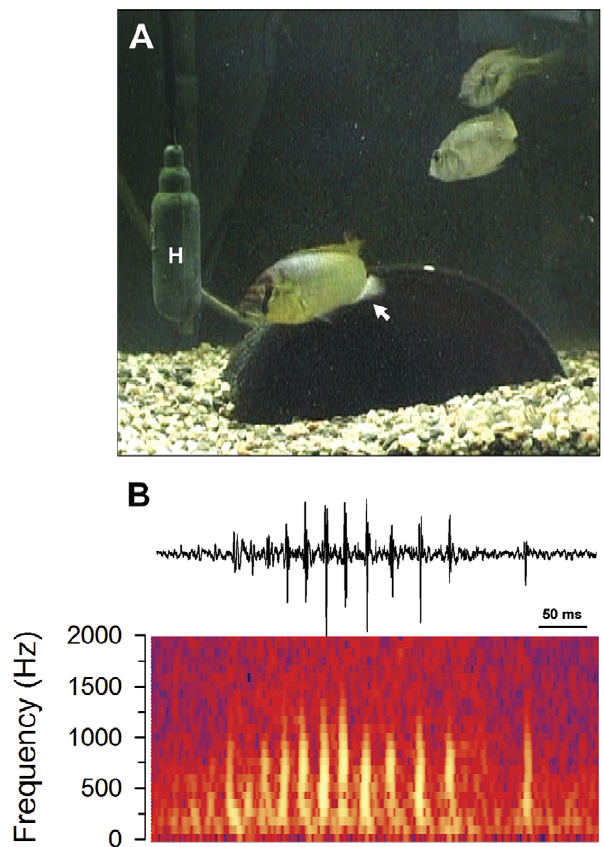
Figure 1. Dominant male Astatotilapiaburtoni produce pulsed sounds during courtship quiver behaviors towards females. A) Photograph of a yellow dominant male in front of his pot territory performing a quiver display and courtship sound while presenting his anal fin egg-spots (arrow) towards two nearby, and attentive, gravid females. H, hydrophone. B) Representative waveform (top) and spectrogram (bottom) of a pulsed broadband courtship sound produced by a dominant